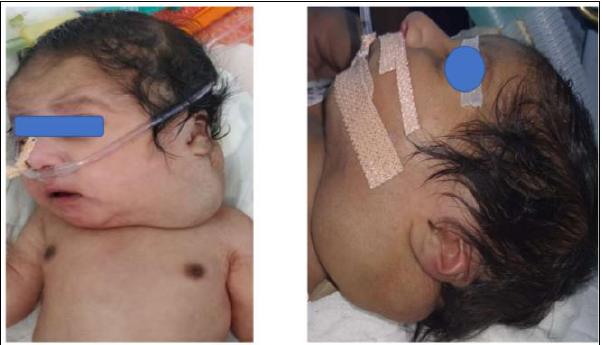
Figure 1: Cystic hygroma on the left side of neck, soft cystic lesion of size 8*7cm. Surgery for TEF was performed by open right postero- lateral thoracotomy. The upper and lower pouch were moderately developed with a wide fistula and a gap of 2 cm. Ligation of the fistula and end to end anastomosis of the esophagus was done. The postoperative period was uneventful and NG feeds were started after 24 hours. On postoperative day 7,